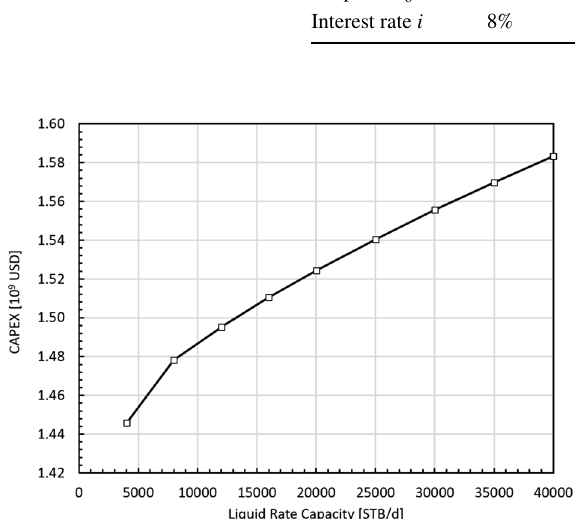
Table 3 Numerical values of key field development parameters